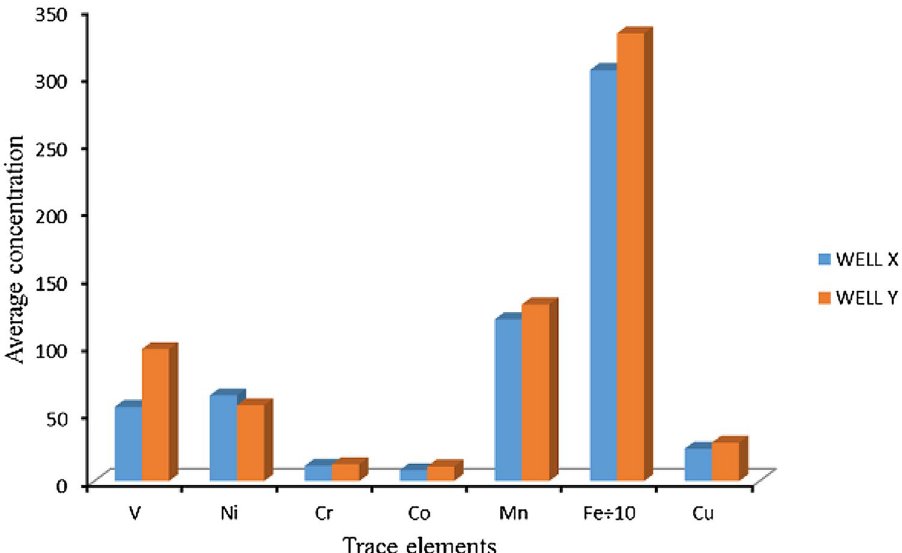
Fig. 3 Relative distribution of trace elements in kerogens from the wells